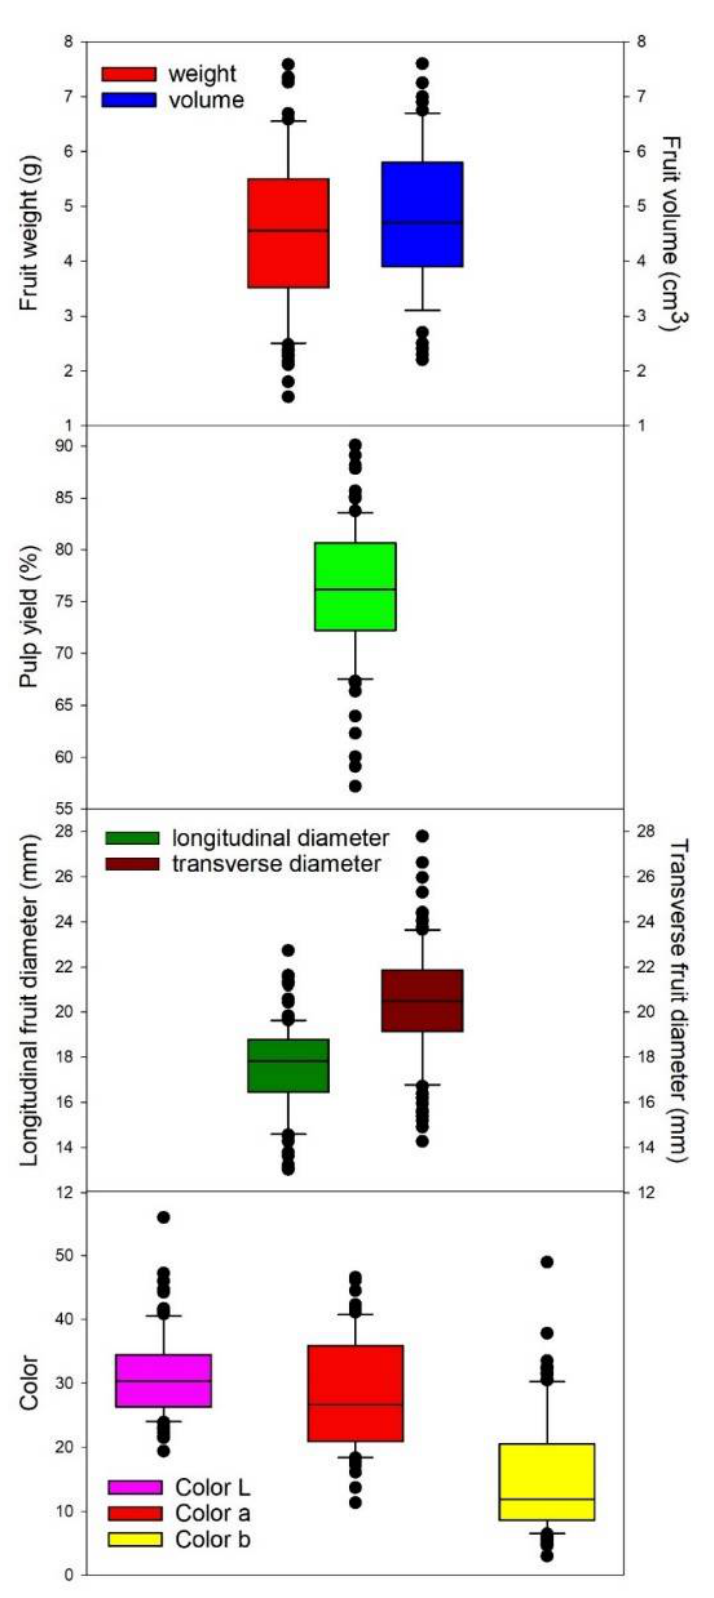
Figure 3. Box plots of physical parameters. Whiskers (error bars) above and below the box indicate the 90th and 10th percentiles. The horizontal line shows the median value. Symbols display extreme data points. Each dot represents the mean value of 4 replicates of ten fruits each.